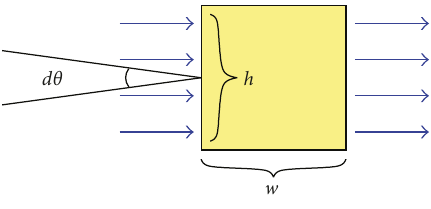
Figure 2: Cumulative progress in a small square.